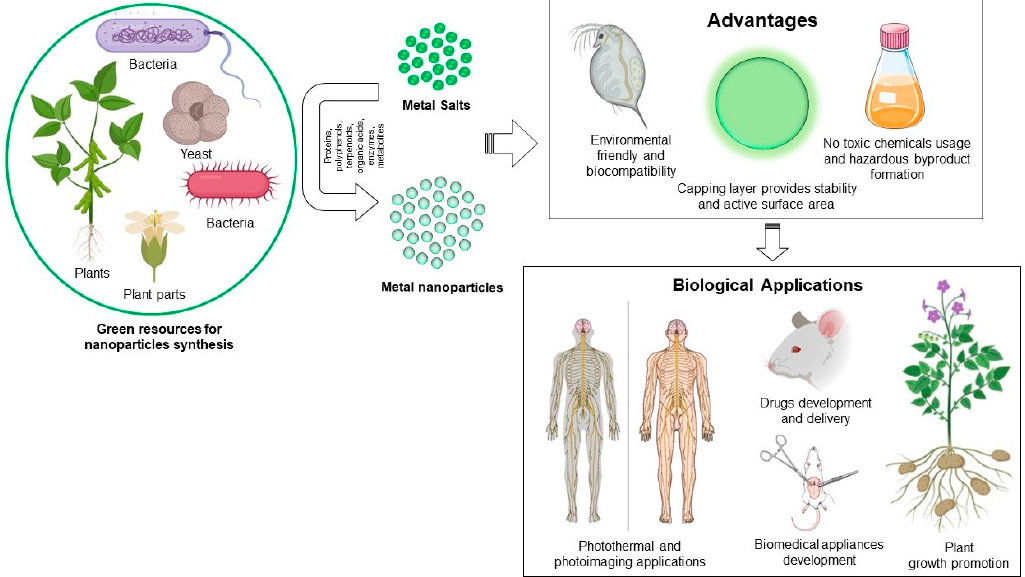
Figure 1. Green synthesis of metallic nanoparticle, their advantages and biological applications.